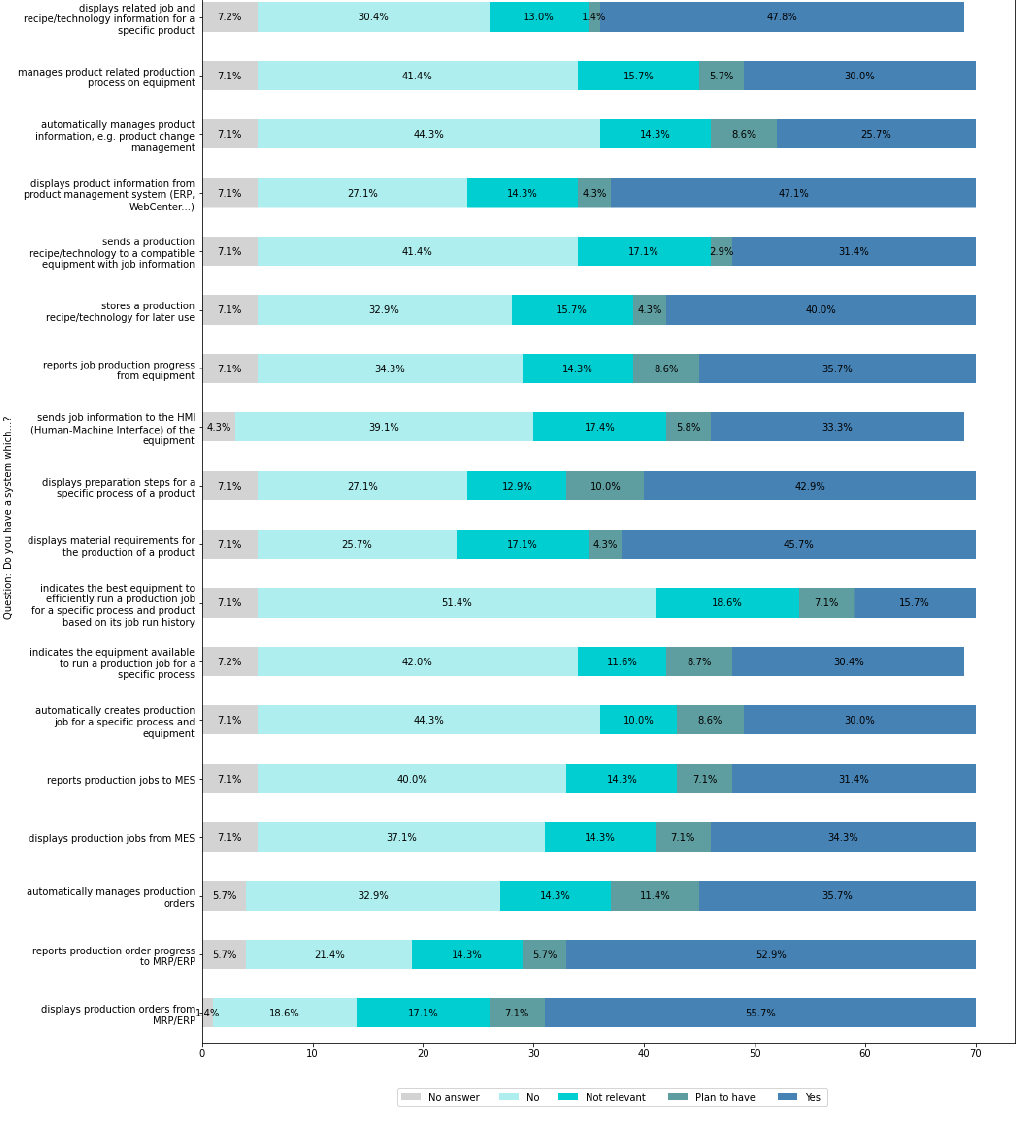
Figure 15. The functionalities of the systems implemented in the companies — number of question- naires in a total number of 70 questionnaires.